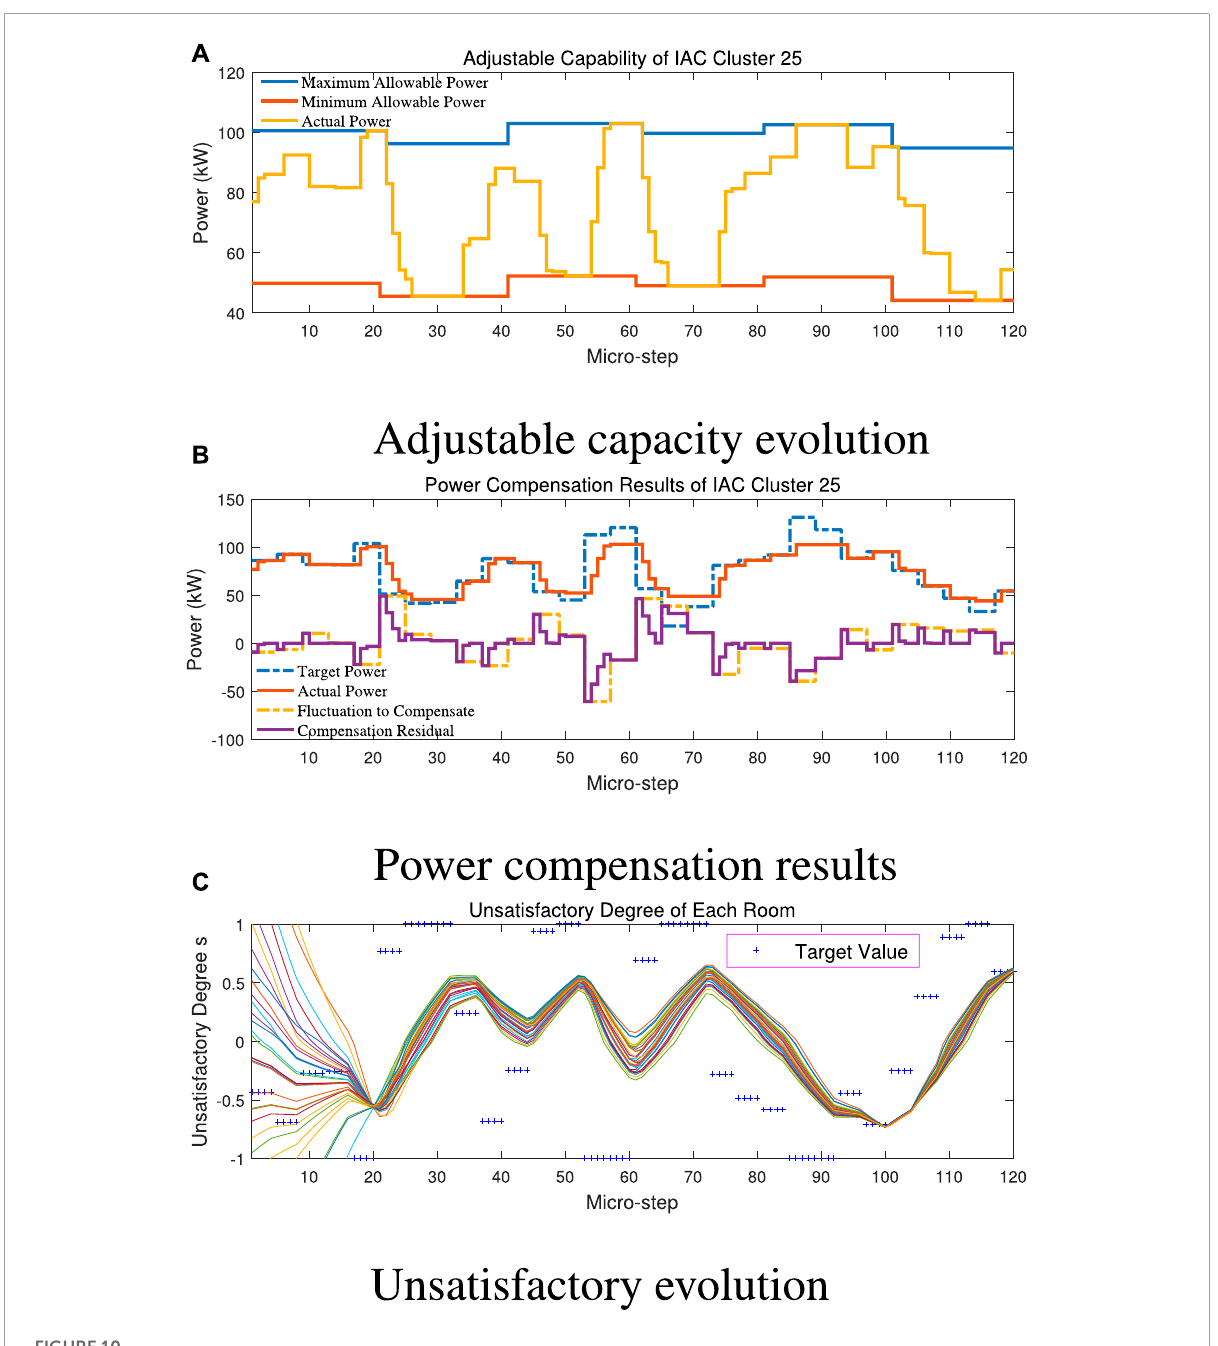
FIGURE 10 Results of real-time control with large power adjustment signal. (A) Adjustable capacity evolution. (B) Power compensation results. (C) Unsatisfactory evolution.